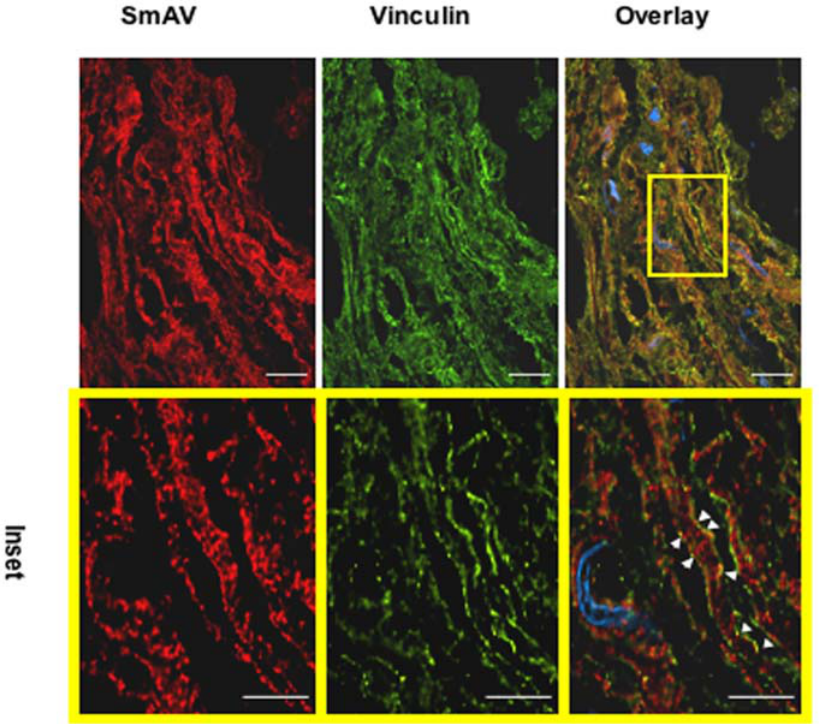
Figure 9. Smooth muscle Archvillin (SmAV) in pregnant human myometrium is localized with vinculin at cell surface. Term, not-in- labor, human uterine smooth muscle strips were microdissected and stretched to 2 fold slack length for 7 minutes. The fresh frozen sections (10 sections for each sample) were stained with rabbit anti-SmAV and mouse anti-vinculin. Alexa-dye-conjugated goat secondary antibodies were used. Left column, SmAV (red); middle column vinculin (green); right column, merged image. Top panels, scale bar, 20 m m. Lower 3 panels, expanded magnification of boxed area in top merged image. SmAV localizes with the dense plaque maker vinculin (inset, white arrows) at cell surface. Scale bar, 10 m m, n=3.